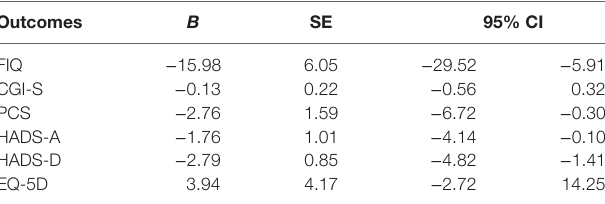
TaBle 4 | Indirect effects of AAQ-II ( n = 35).